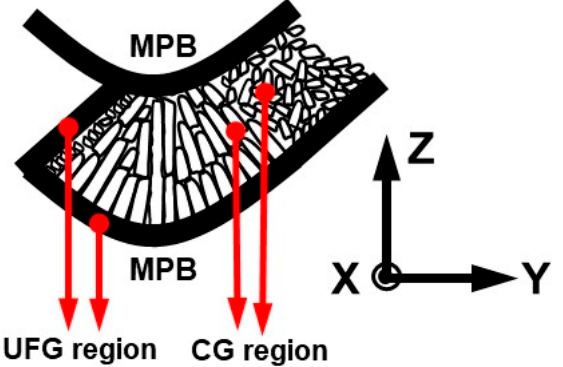
Figure 3. Schematic of the microstructural features of the as-built Scalmalloy.